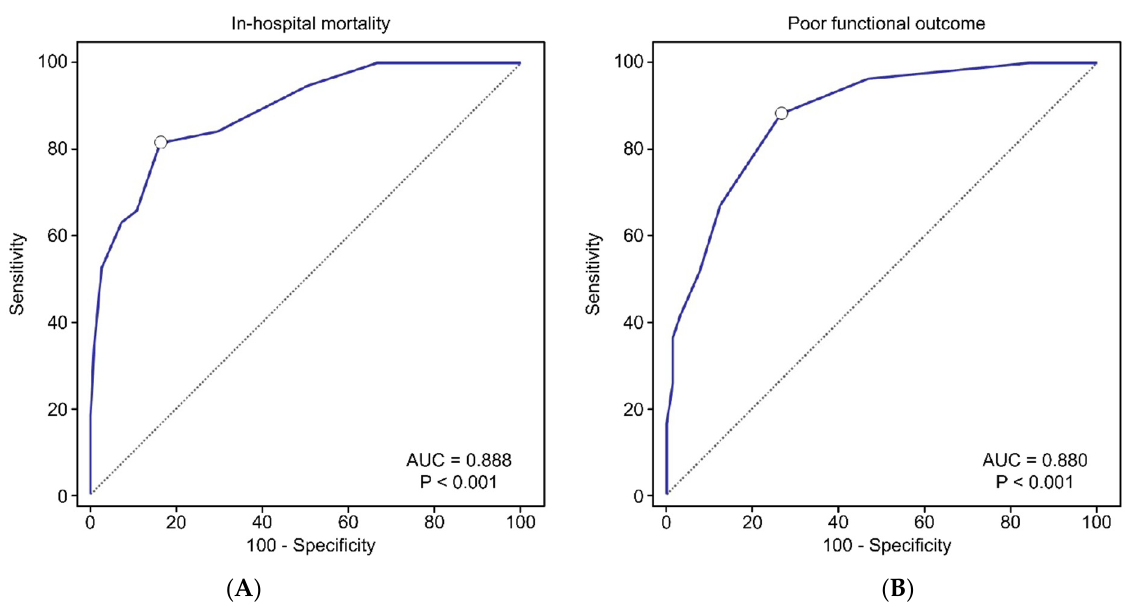
Figure 2. Receiver operating characteristic curves of the Traumatic Graeb Score in predicting in- hospital mortality ( A ) and poor functional outcome ( B ). AUC: area under the curve; mRS: modified Rankin Scale.